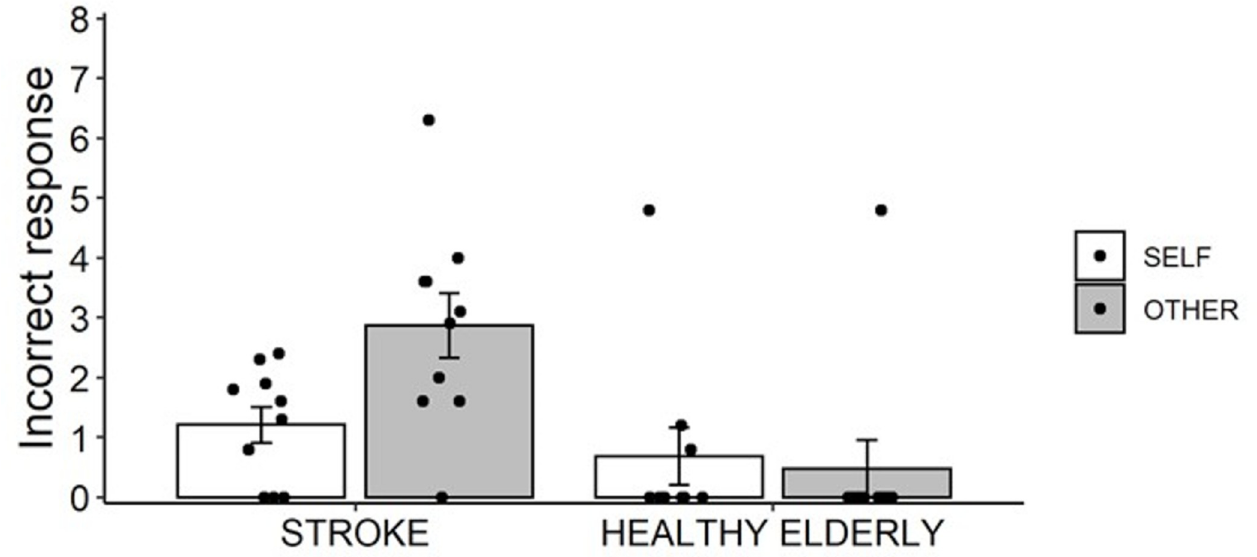
Fig 6. Incorrect responses (i.e., misattributions) in the self-other judgments of post-stroke patients and healthy elderly individuals. In post-stroke patients, differences in the average number of incorrect responses between the paretic and non-paralyzed upper limbs were calculated. The error bars indicate standard